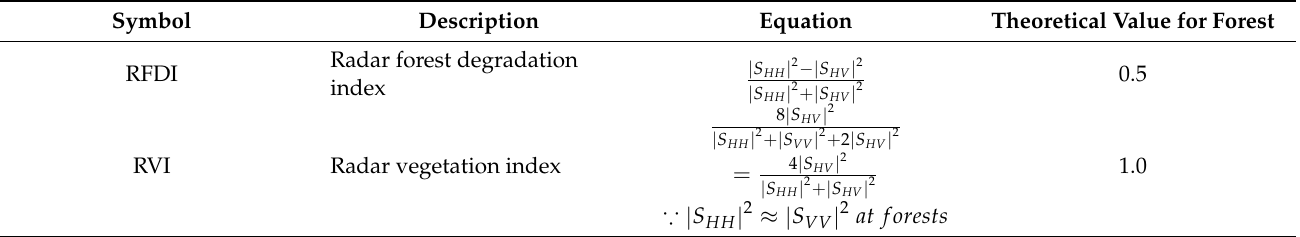
Table 3. Vegetation indices proposed in previous